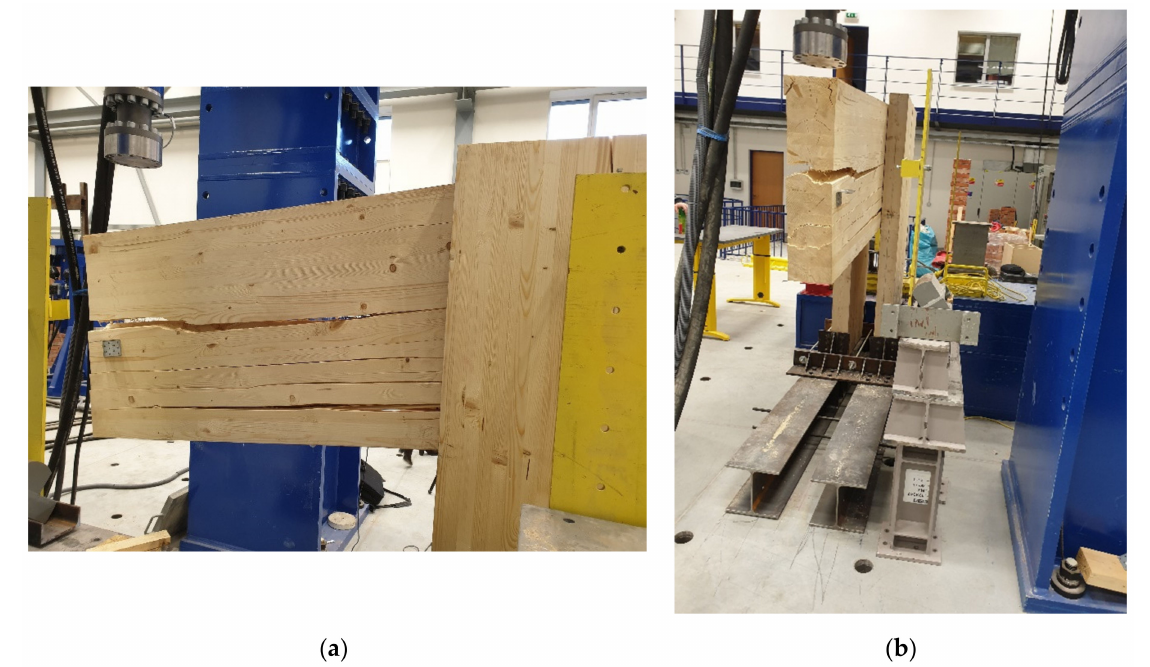
Figure 20. Experiment no. 2: ( a ) damage test sample no. 3; ( b ) damage test sample no. 3.